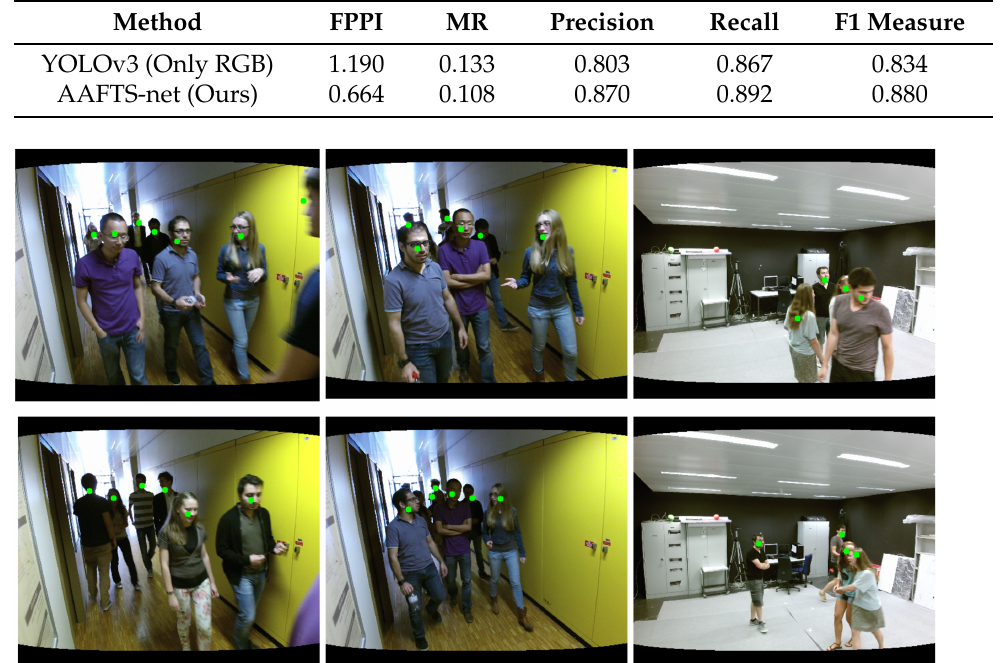
Figure 8. Detection results obtained under conditions of frequent occlusion, where the green points are the center points of the predicted bounding